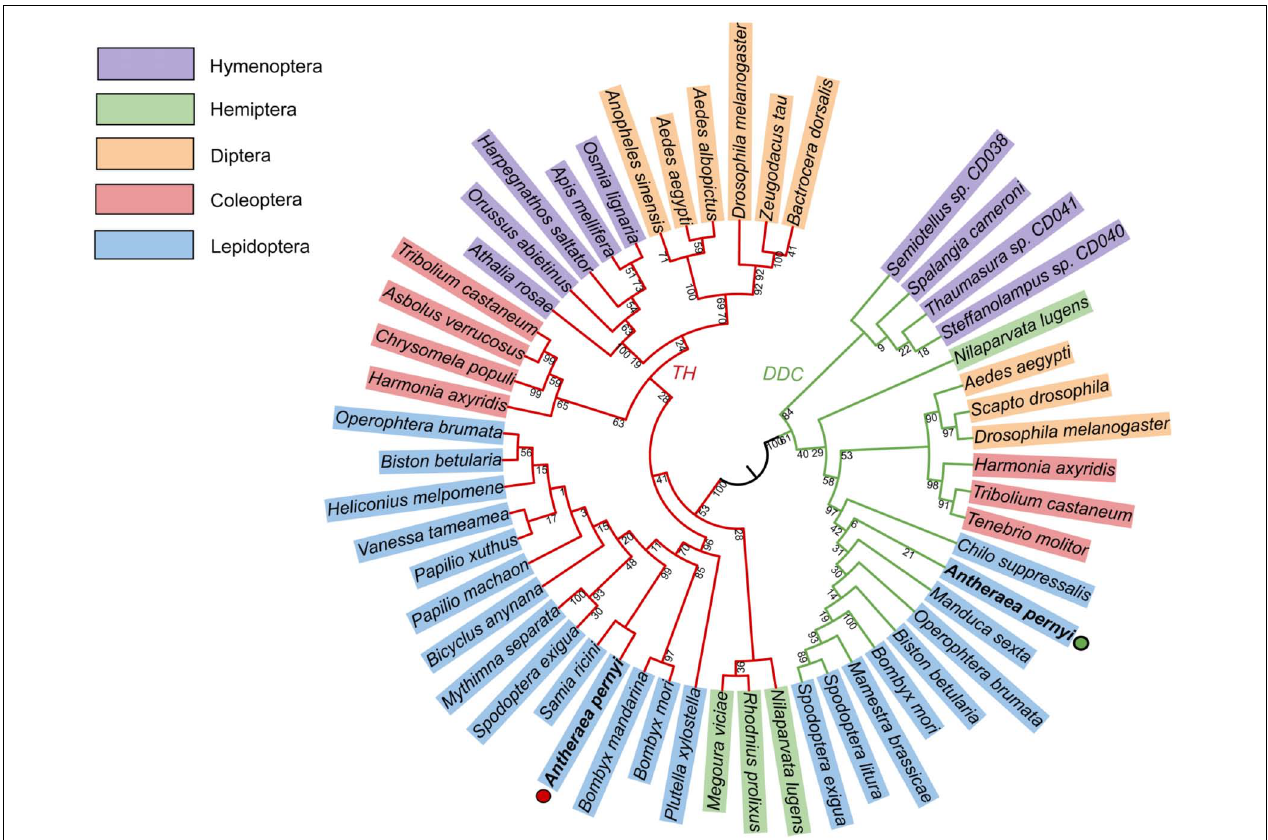
FIGURE 3 | Phylogenetic tree constructed using TH and DDC sequences of different insect species with MEGA7.0. Bootstrap percentage values are marked on the red (TH) and green (DDC) branches. GenBank accession numbers are shown as follows. TH: Bactrocera dorsalis (AVP73886.1); Zeugodacus tau (QBE90477.1); Drosophila melanogaster (CAA53802.1); Aedes albopictus (XP_019527163.2); Aedes aegypti (XP_021696291.1); Anopheles sinensis (AMZ03511.1); Apis mellifera (NP_001011633.1); Harpegnathos saltator (EFN85710.1); Orussus abietinus (XP_012279464.1); Athalia rosae (XP_012269076.1); Tribolium castaneum (NP_001092299.1); Asbolus verrucosus (RZC40828.1); Chrysomela populi (AWK23447.1); Harmonia axyridis (QER78576.1); Operophtera brumata (KOB71174.1); Biston betularia (ADF43213.1); Heliconius melpomene malleti (ADU32895.1); Vanessa tameamea (XP_026500806.1); Papilio machaon (NP_001303944.1); Papilio xuthus (NP_001299711.1); Bicyclus anynana (AGT62463.1); Mythimna separata (BAF32573.1); Spodoptera exigua (AFG25778.1) ; Samia ricini (BAF64534.1); Bombyx mori (NP_001138794.1); Bombyx mandarina (ADV56709.1); ApTH- Antheraea pernyi (QZU75311.1); Plutella xylostella (NP_001292449.1); Megoura viciae (ASU09659.1); Rhodnius prolixus (ANZ03350.1); Nilaparvata lugens (QEE04288.1); Osmia lignaria (XP_034181574.1). DDC: Drosophila melanogaster (NP_523600.5); Aedes aegypti (AAC31639.1); Tribolium castaneum (ABU25222.1); Harmonia axyridis (AMQ13055.1); Operophtera brumata (KOB76562.1); Biston betularia (ADF43201.1); Spodoptera exigua (AFG25780.1); Spodoptera litura (AHB23865.1); Bombyx mori (AAK48988.1); ApDDC- A. pernyi (QZU75312.1); Nilaparvata lugens (QEE04289.1); Mamestra brassicae (BAB68545.1); Manduca sexta (QDR50989.1); Chilo suppressalis (AKL78850.1); Tenebrio molitor (BAA95568.1); Scapto drosophila (AAC67585.1); Steffanolampus sp. CD040 (ABJ90384.1); Thaumasura sp. CD041 (ABJ90385.1); Spalangia cameroni (ABJ90383.1); Semiotellus sp. CD038 (ABJ90382.1).